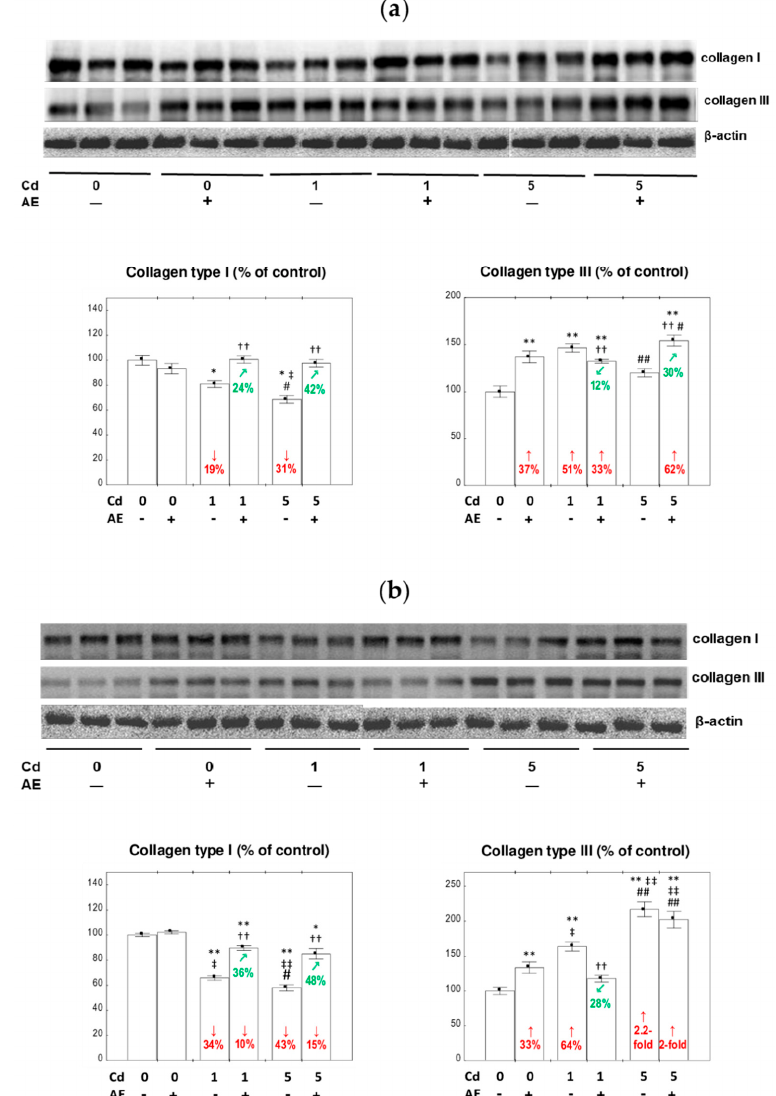
Figure 3. The impact of Aronia melanocarpa L. berry extract (AE) on the expression of collagen type I and collagen type III at the protein level in the livers of rats exposed to cadmium (Cd) for 3 ( a ) and 10 ( b ) months. The animals were treated with Cd at the concentrations of 0, 1, and 5 mg Cd/kg in their diets and/or 0.1% aqueous AE (+) or not ( − ). Representative gels of Western blotting are presented. Data are shown as mean ± SE for eight rats. Statistically significant differences (Kruskal–Wallis post hoc test): * p < 0.05 and ** p < 0.01 vs. control group; †† p < 0.01 vs. appropriate Cd group; ‡ p < 0.05 and ‡‡ p < 0.01 vs. AE group; # p < 0.05 and ## p < 0.01 vs. appropriate group maintained on the 1 mg Cd/kg diet (Cd 1 group or Cd 1 + AE group). Numerical values in bars express the percentage changes or factors of changes in comparison to the control group ( ↑ , increase; ↓ , decrease) or the appropriate group exposed to Cd alone ( ↗ , increase; ↙ , decrease).